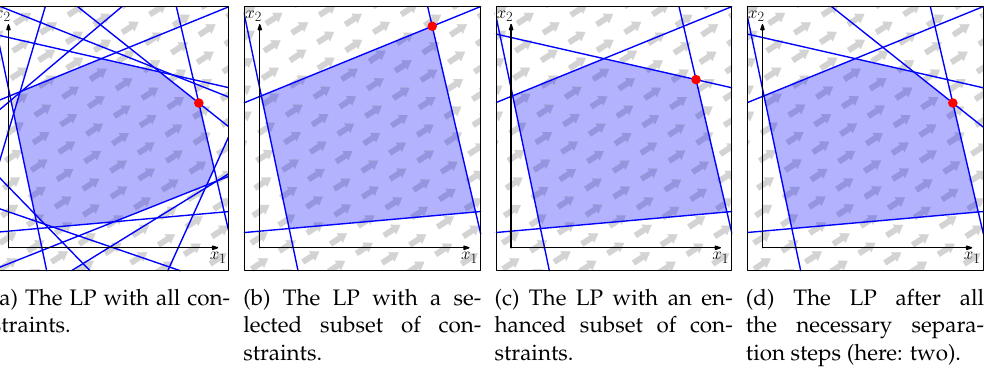
Figure 3: A geometric interpretation of an LP with two variables x 1 , x 2 ∈ R (constraints presented as blue lines, objective function presented as gray arrows) and its solution (red). While (a) depicts the complete LP and an optimal solution, (b) to (d) show the advantages of using a separation algorithm: Starting with only a subset of constraints (b) we extend the LP with constraints which are violated by the solution to the current LP (c) as long as we can find any (see Figure 4). When the separation algorithm cannot find any violations (d) the current solution is valid and optimal with respect to the complete LP of the original model.